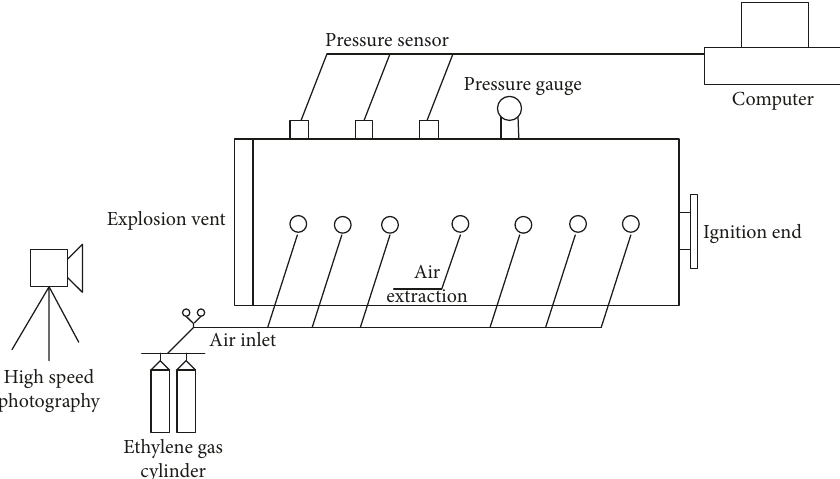
Figure 4: Schematic diagram of the test device.